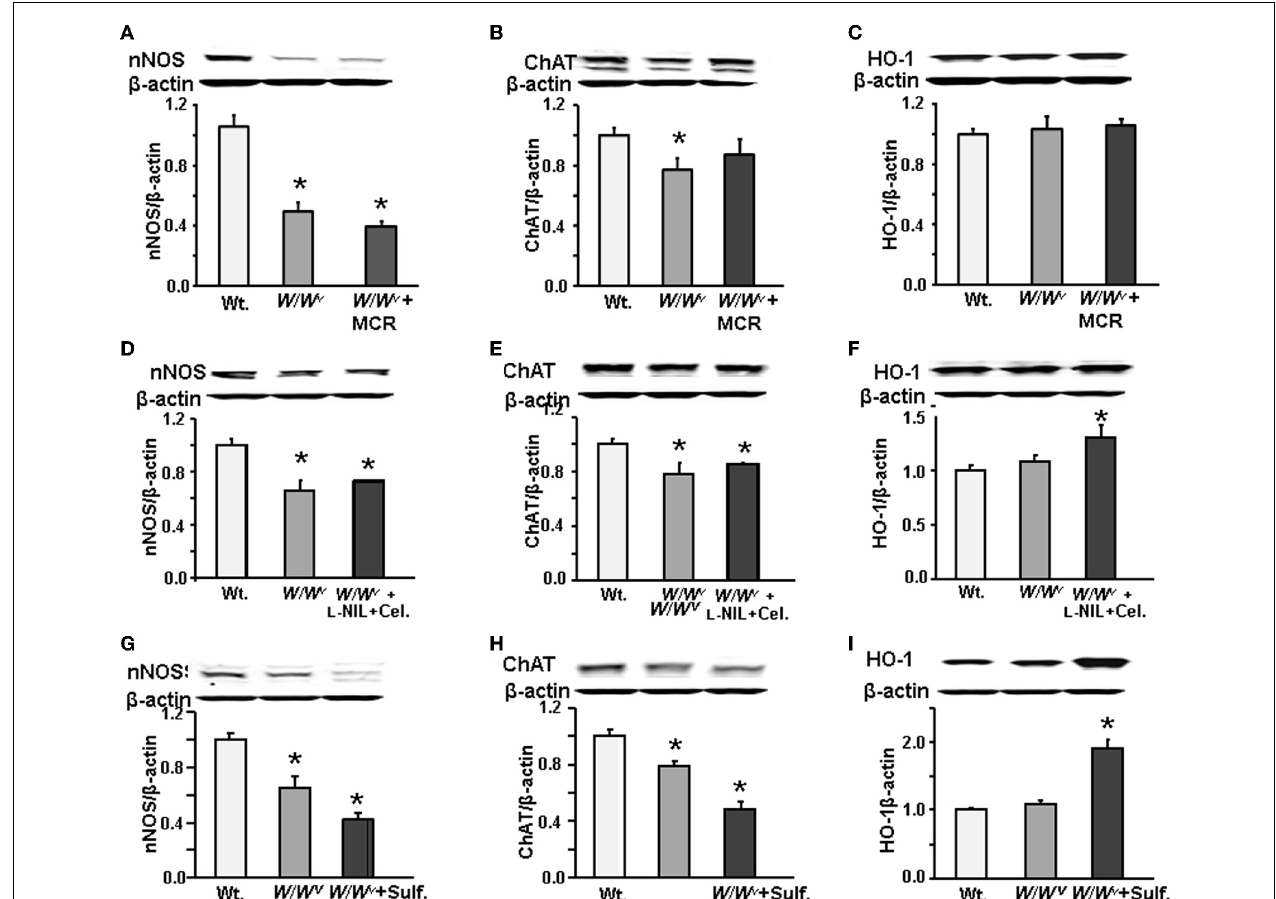
FIGURE 6 | Western blots showing nNOS, ChAT and HO-1 expression in WT, W/W v , and W/W v + MCR mice. (A) nNOS expression decreased in W/W v vs. wild type (WT) mice, mast cell reconstitution did not restore it. (B) ChAT expression decreased in W/W v mice, mast cell reconstitution restored it partially. (C) There was no significant difference in HO-1 expression between WT and W/W v mice. Mast cell reconstitution in W/W v mice had no effect on heme oxygenase (HO-1) expression. (D) , (E), and (F) Combined L-NIL and celecoxib (Cel.) had no effect on the down regulation of nNOS or ChAT, but they